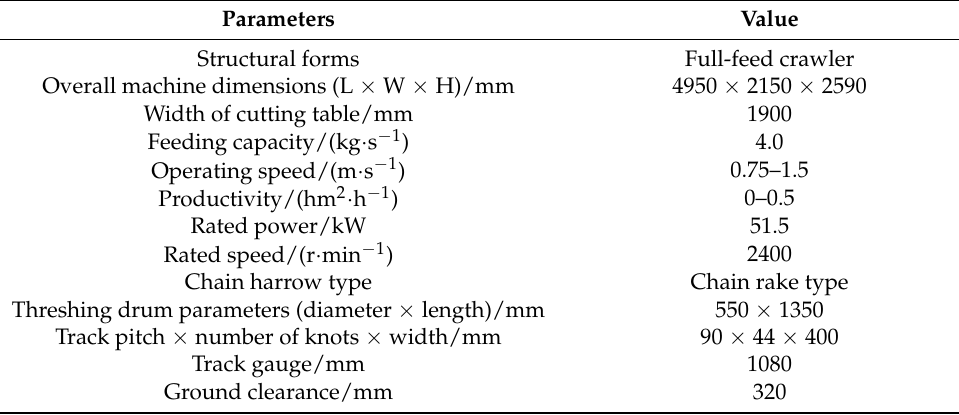
Figure 2. The 4LZ-4.0 flax combine structure schematic and prototype diagram: ( a ) Schematic diagram of the structure; ( b ) prototype drawing. (1) Awning. (2) Operating lever. (3) Driver’s platform. (4) Over-bridge. (5) Wheel spreader. (6) Wheel paddle. (7) Splitter. (8) Blade guard. (9) Cutting knife. (10) Guard. (11) Header. (12) Hydraulic cylinder. (13) Driving wheel. (14) Support wheel. (15) Track. (16) Tensioning wheel. (17) Chassis. (18) Oil tank. (19) Shredder. (20) Threshing drum. (21) Grain discharge cylinder. Table 1. Technical parameters of 4LZ-4.0 flax combine harvester.